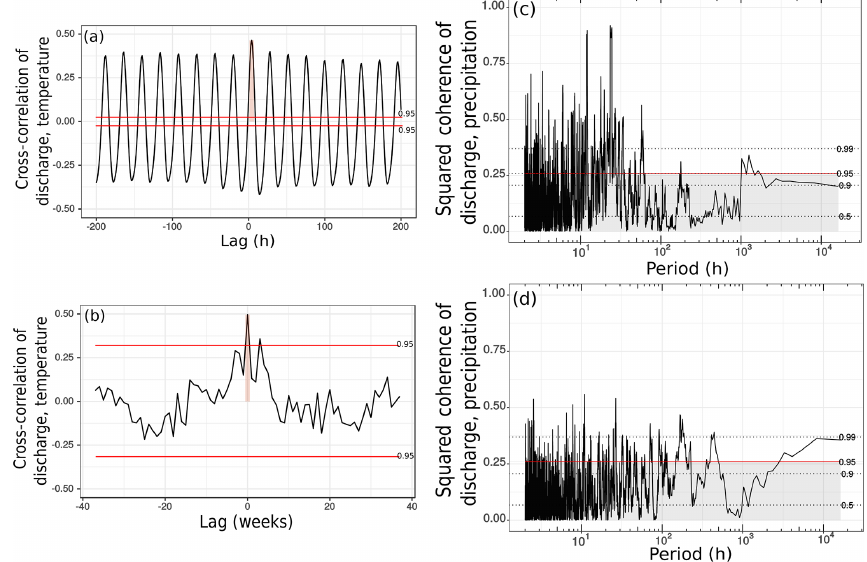
Figure 5. Cross-correlations (with 95% confidence interval shown) of observed discharge at Gavilan Machay with (a) hourly temperature and (b) weekly precipitation show that discharge has a clear diurnal link with temperature at about a 4h lag and a strong relationship with weekly precipitation, respectively. Magnitude squared coherence (with various confidence intervals shown) between discharge and (c) temperature exhibits a high peak at 24h corresponding to the cross-correlation result, as well as a strong peak at 12h, and a more moderate peak at a multi-day scale. The coherence between discharge and (d) precipitation peaks between 100 and 200h (about 1 week) and may also be significant at scales approaching 1